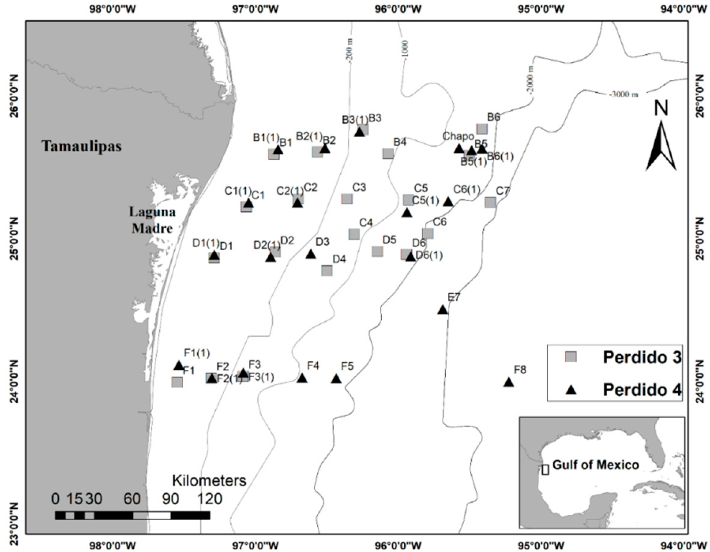
Figure 1. Mollusk sampling sites on Perdido Fold Belt during the Perdido 3 cruise (squares symbol) and Perdido 4 cruise (triangles symbol), in June and September 2017, respectively. Samples were assigned to two water-depth zones: the continental shelf (43–200 m) and bathyal zone (375–3563 m), separated by the 200 m isobath. Acronym: Chapo = oil seep.